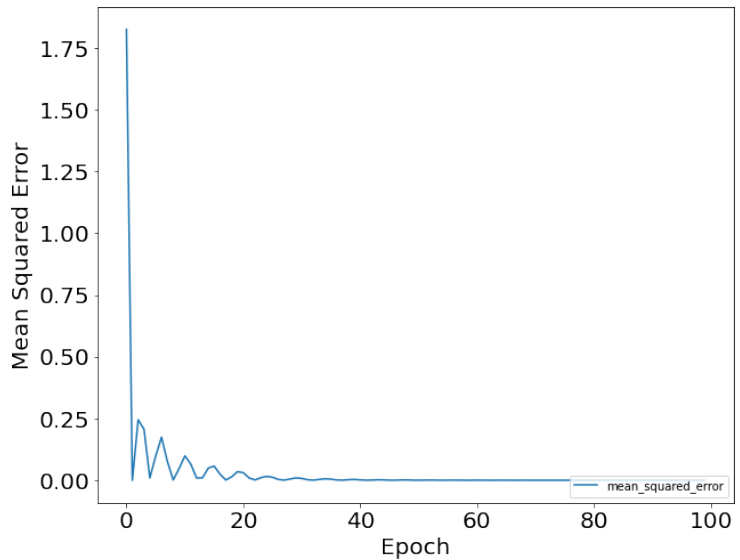
Figure 9. Mean squared error of the model output during training against the validation set.